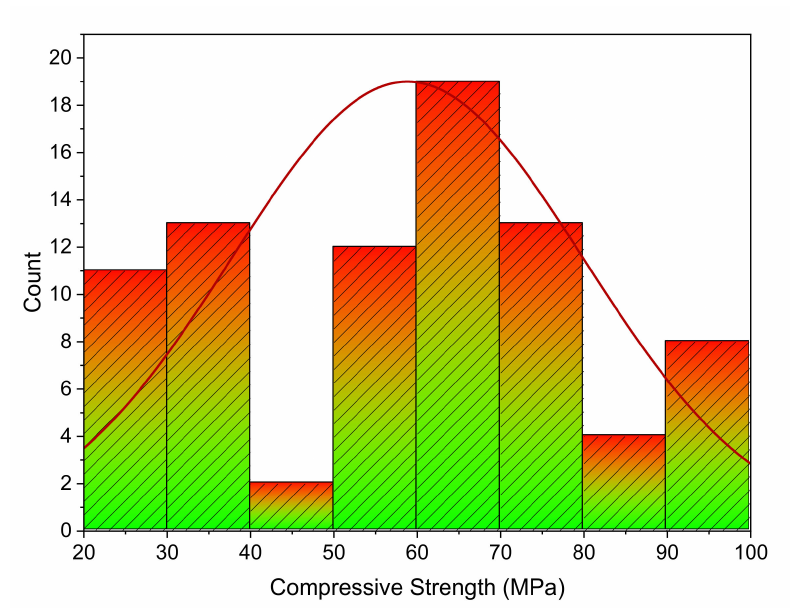
Figure 6. SFRC compressive strength distribution.